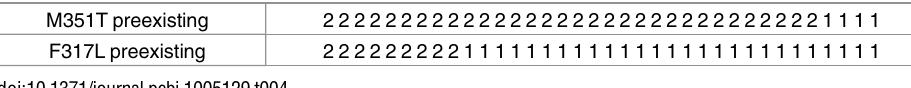
Table 4. Optimal combination